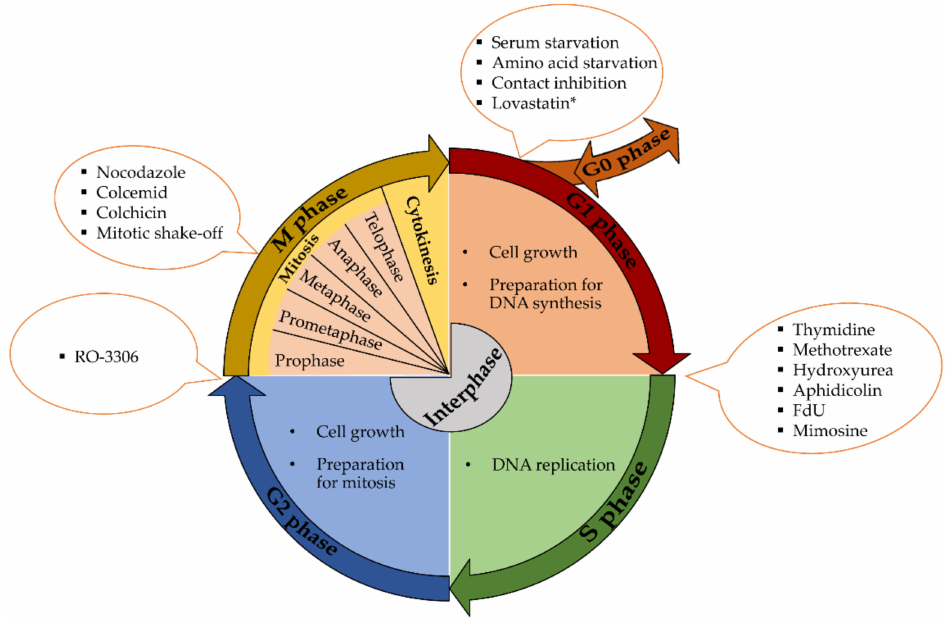
Figure 1. Overview of the cell cycle phases and some synchronization methods. * The stage of G1 phase at which lovastatin exerts its effect is not